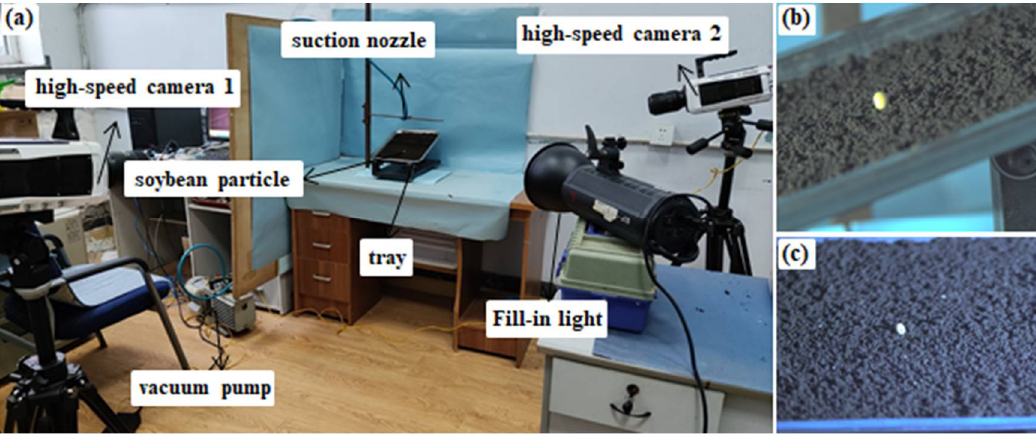
Figure 7. ( a ) Seed throwing test apparatus, the movement of soybean seed particles taken by ( b ) high-speed camera 1 and ( c ) high-speed camera 2.